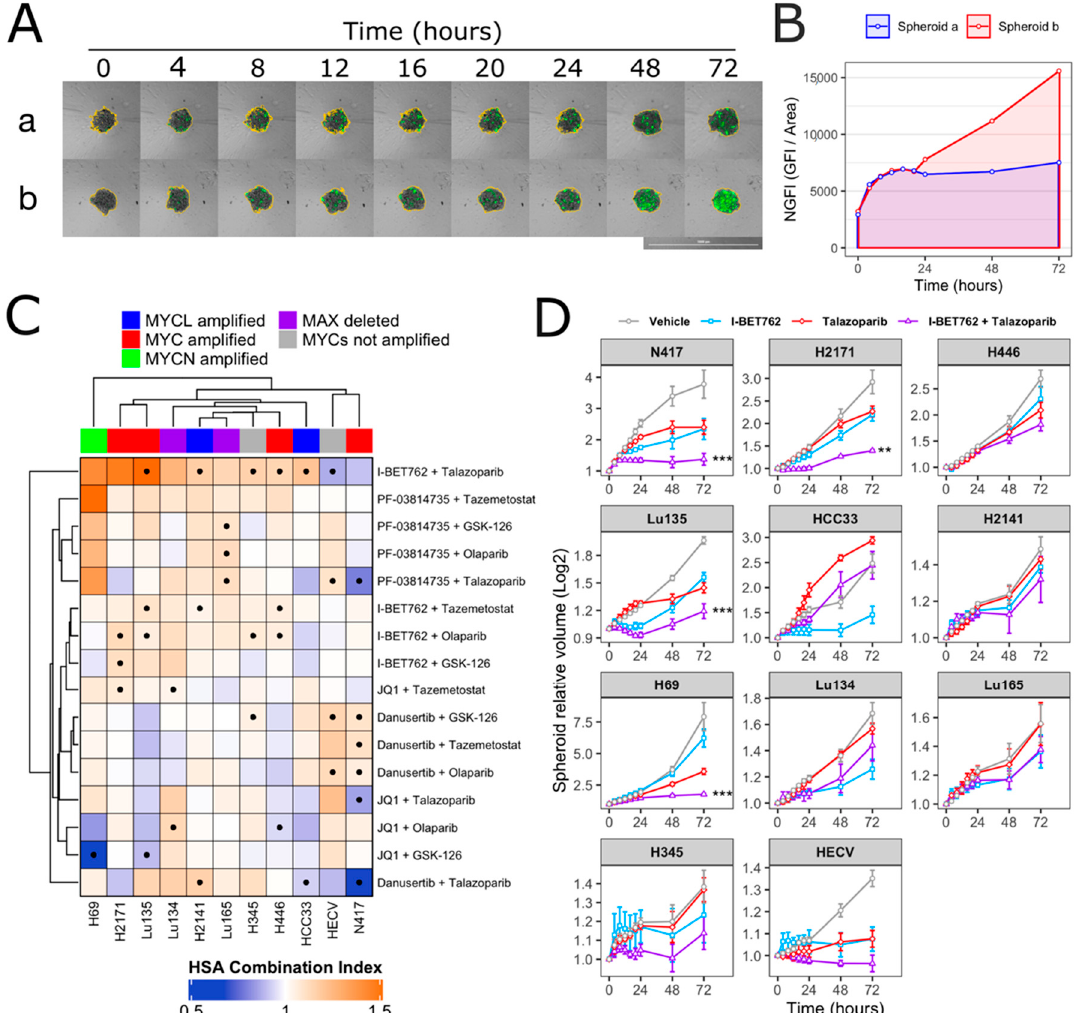
Figure 1. Synergistic e ffi cacy of I-BET762 and Talazoparib on the viability and growth of small cell lung cancer (SCLC) cells. ( A ) Merged brightfield and green fluorescence images of representative Lu135 untreated (a) or I-BET762 and Talazoparib combination-treated (b) spheroids over 72 h of culture. Spheroid edges, shown in yellow, were used to measure spheroid volumes and Green Fluorescence Integral (GFI), representative of relative number of cells and relative number of dead cells, respectively. Bar of 1,000 µ M is shown bottom right. ( B ) Normalized GFI of spheroids shown in (A). Area under a curve of normalized GFI (NGFI) was used as a parameter representative of kinetics of cytotoxicity over a period of 72 h. ( C ) Heatmap showing Highest Single Agent Combination Index (HSA-CI) of NGFI, representative of cell death. A black dot inside the squares indicates a Benjamini-Hochberg corrected p -value < 0.05. ( D ) Timeplot of volumes of I-BET762 and Talazoparib-treated spheroids (relative to start of treatment). Values shown mean ± SE. ** p < 0.01, or *** p < 0.001 BH-adjusted HSA Combination Index CDF.